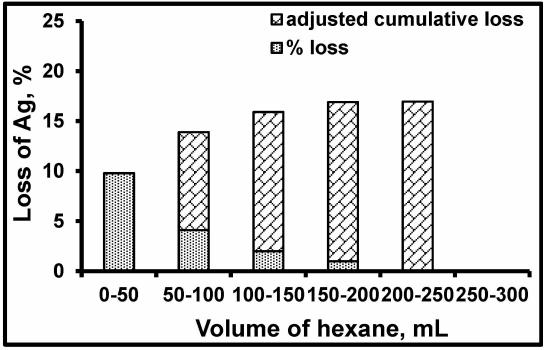
Figure 9. Percent loss of Ag from Ag/SiO 2 under flow conditions using hexane as the solvent.